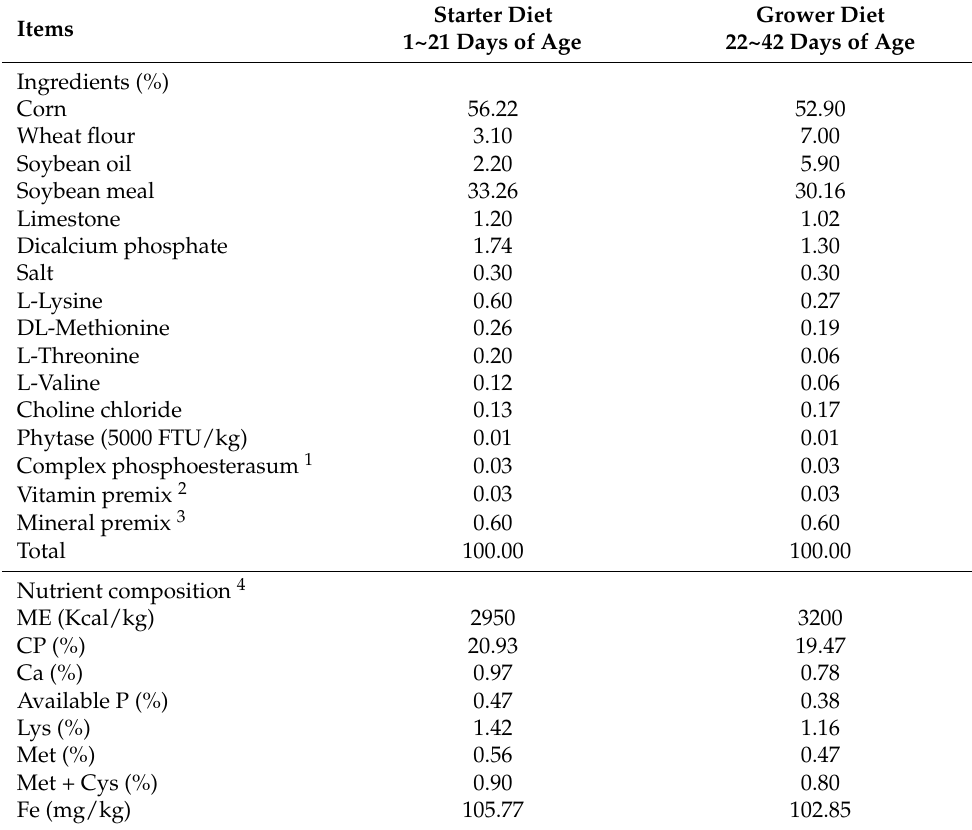
Table 1. Ingredient composition and nutrient level of the basal diets (air ‐ dry basis).